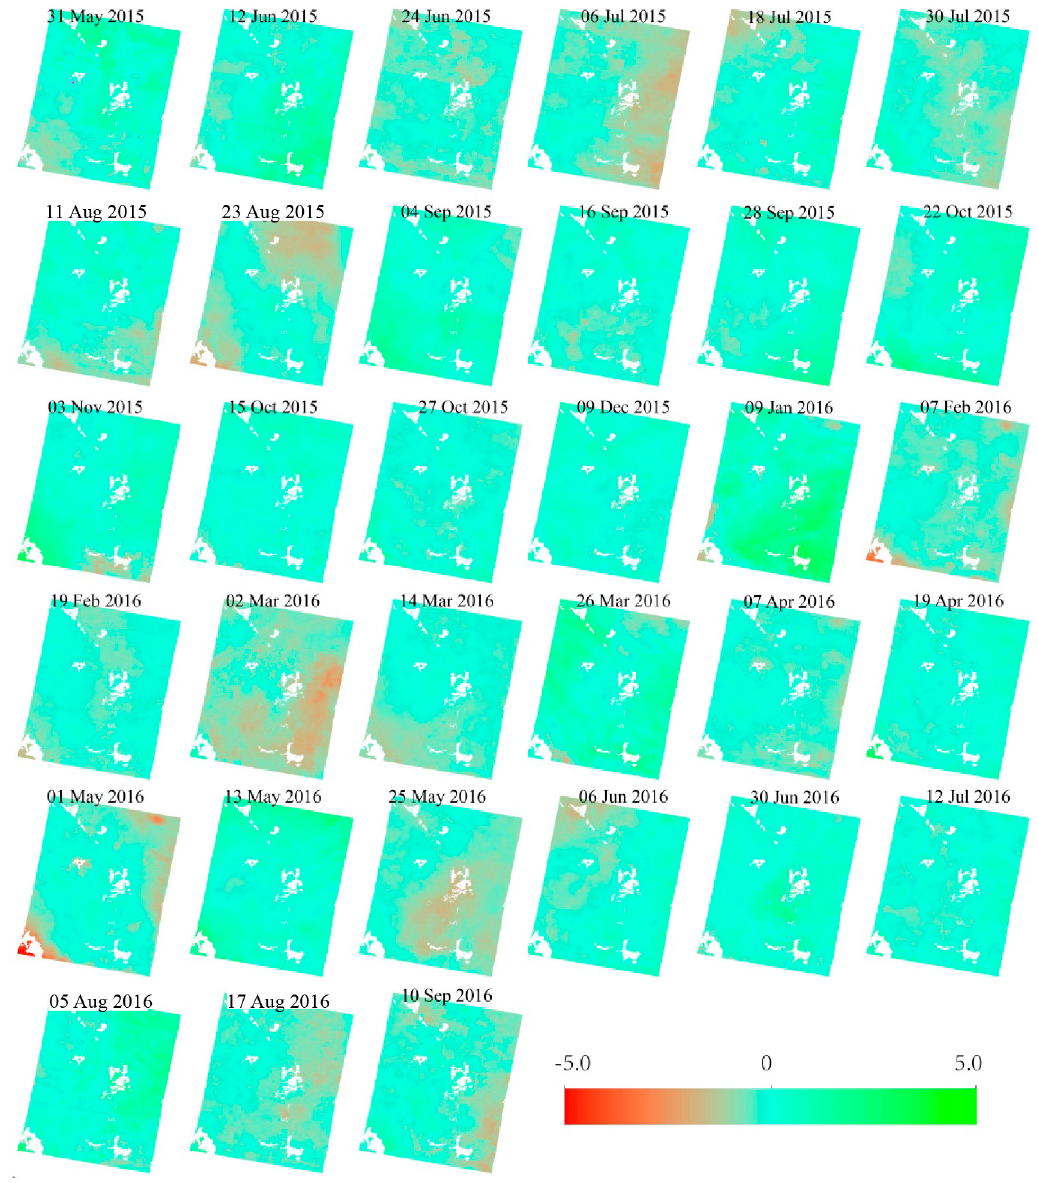
Figure 8. Atmospheric time-series generated by Method III in the LOS direction (unit: cm).